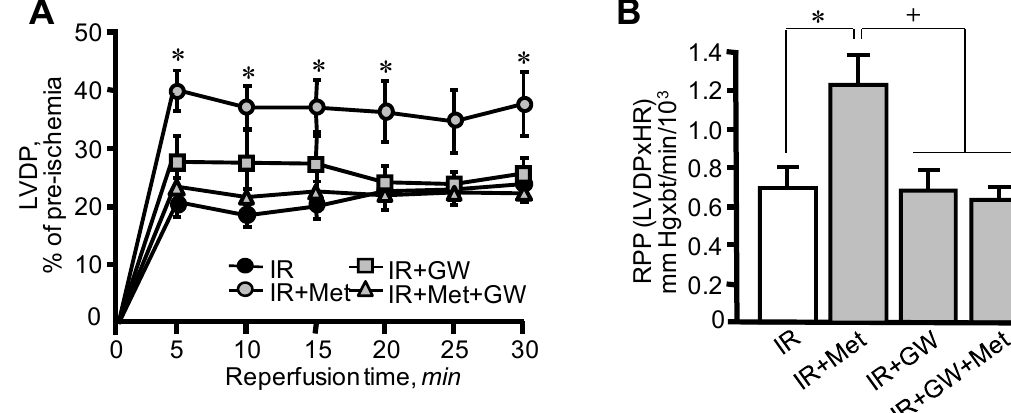
Figure 2. The effects of metformin (Met) on post-ischemic recovery in hearts in the presence or absence of GW6471 (GW). ( A ) Left ventricular (LV) developed pressure (LVDP) calculated as the difference between LV systolic pressure and LV end-diastolic pressure (LVEDP). Data are expressed as percent of pre-ischemic values. ( B ) Rate-pressure product (RPP), an indicator of heart performance calculated as LVDP × heart rate (HR). Data are expressed in mm Hg × beats per min. * p < 0.05 IR+Met vs. IR; + p < 0.05 IR+GW or IR+Met+GW vs.